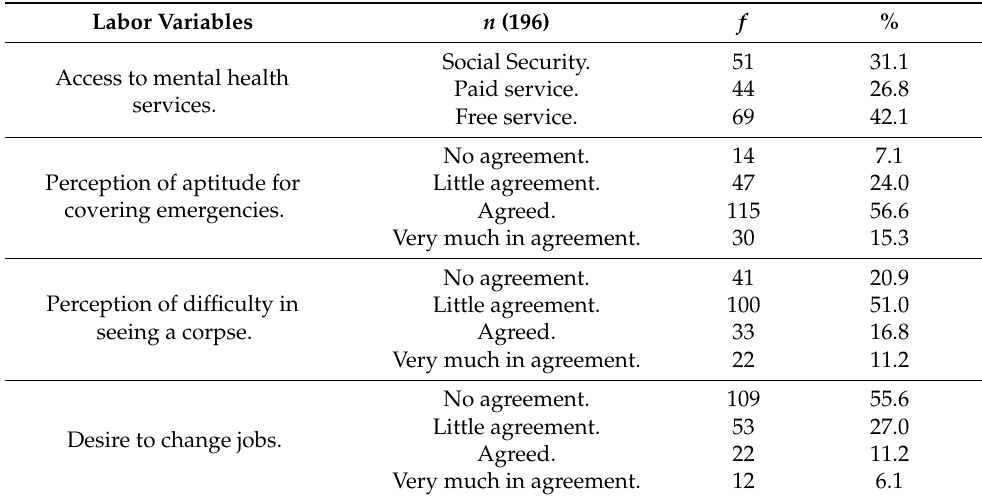
Table 3. Factors related to the journalist’s work. Labor Variables